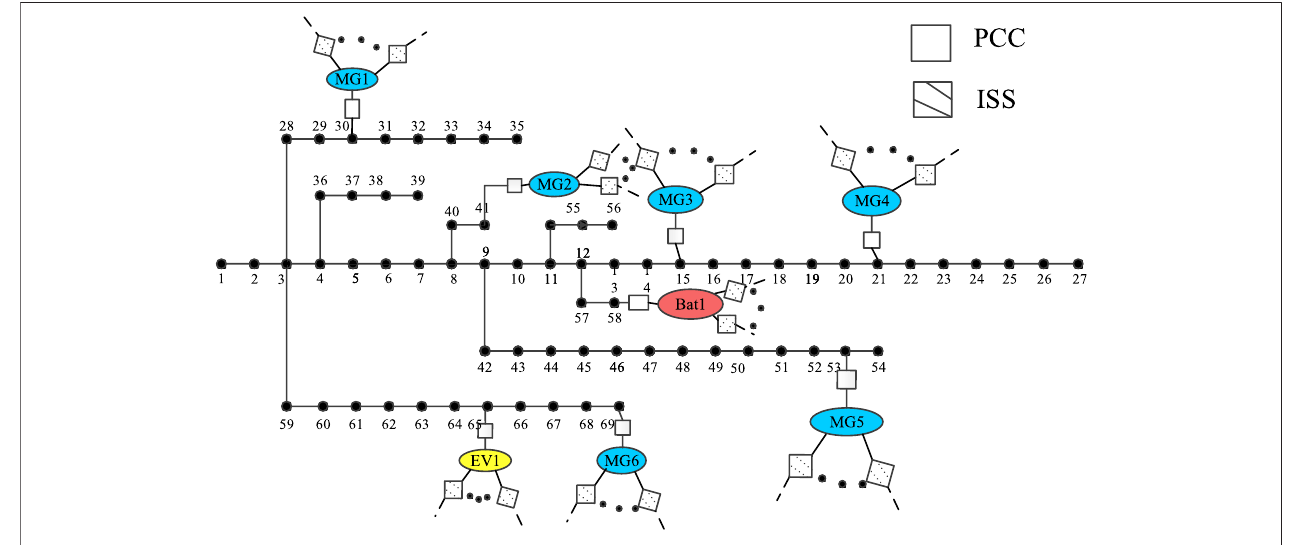
FIGURE 3 | Distribution of the multi-stakeholder in PG&E69-bus distribution system.